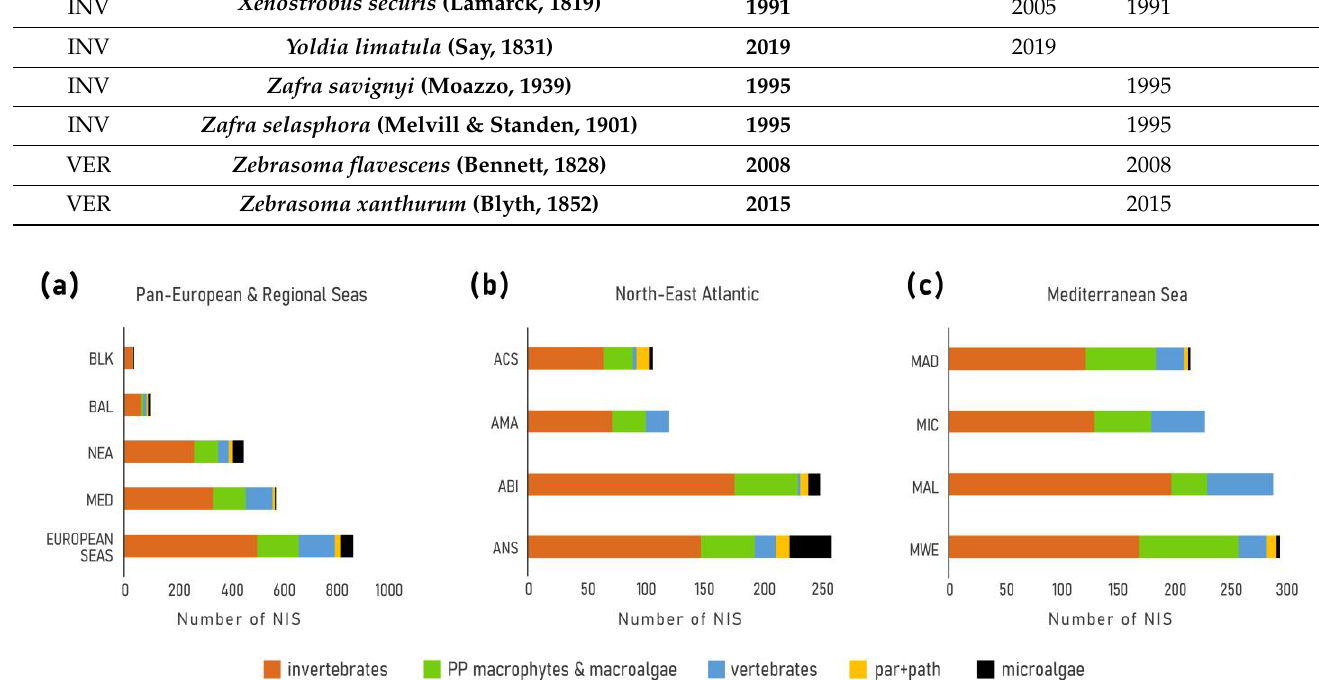
Figure 2. Number of NIS detected by December 2020. ( a ) European waters and regional Seas, ( b ) North-East Atlantic subregions: ANS = Greater North Sea, ABI = Bay of Biscay-Iberian Shelf, AMA = Macaronesia, ACS = Celtic Seas; ( c ) Mediterranean subregions: MWE = Western Mediterranean, MAL = Eastern Mediterranean, MIC = Central Mediterranean, MAD = Adriatic Sea.